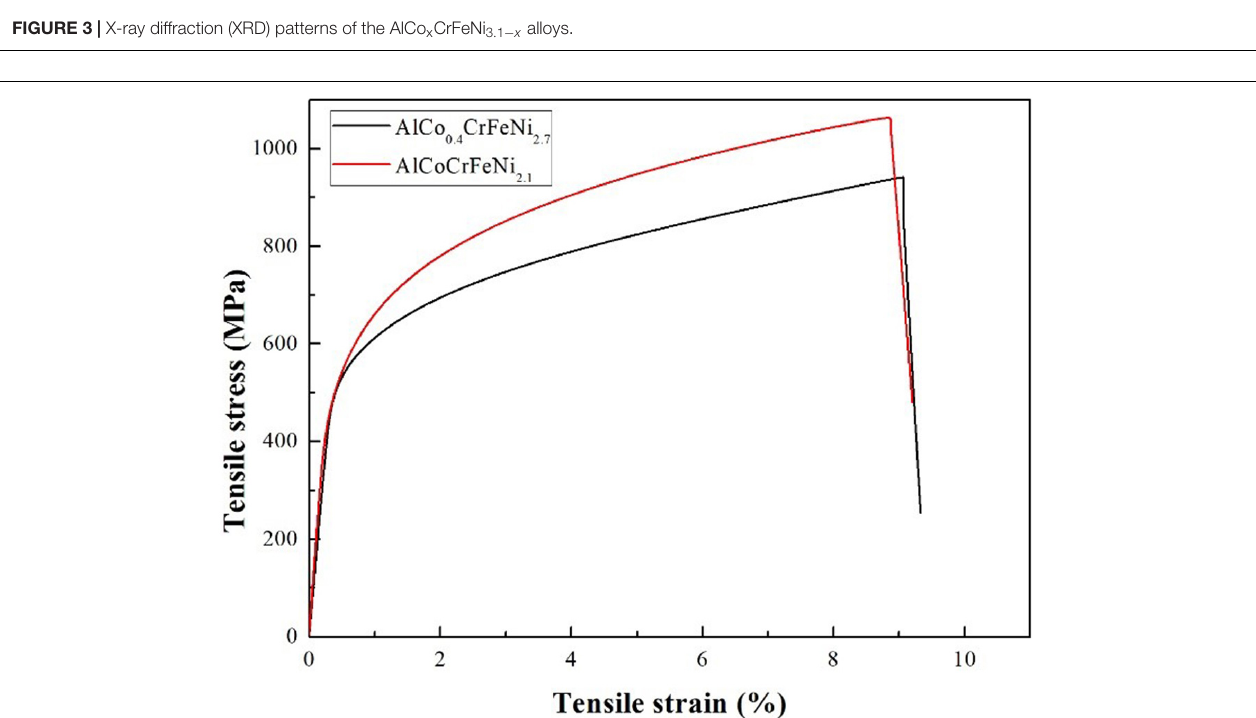
FIGURE 4 | Engineering tensile stress-strain curves of the AlCo x CrFeNi 3 . 1 − x